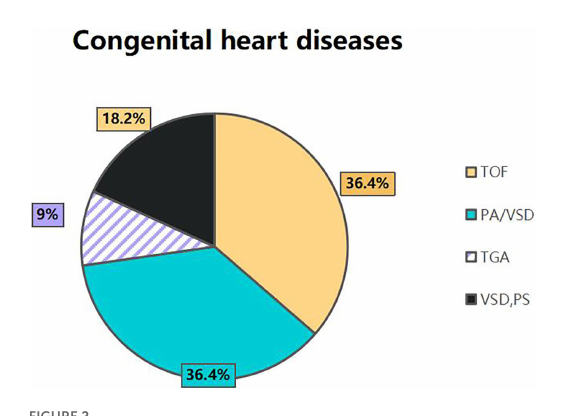
FIGURE2 The distributions of congenital heart diseases in 11